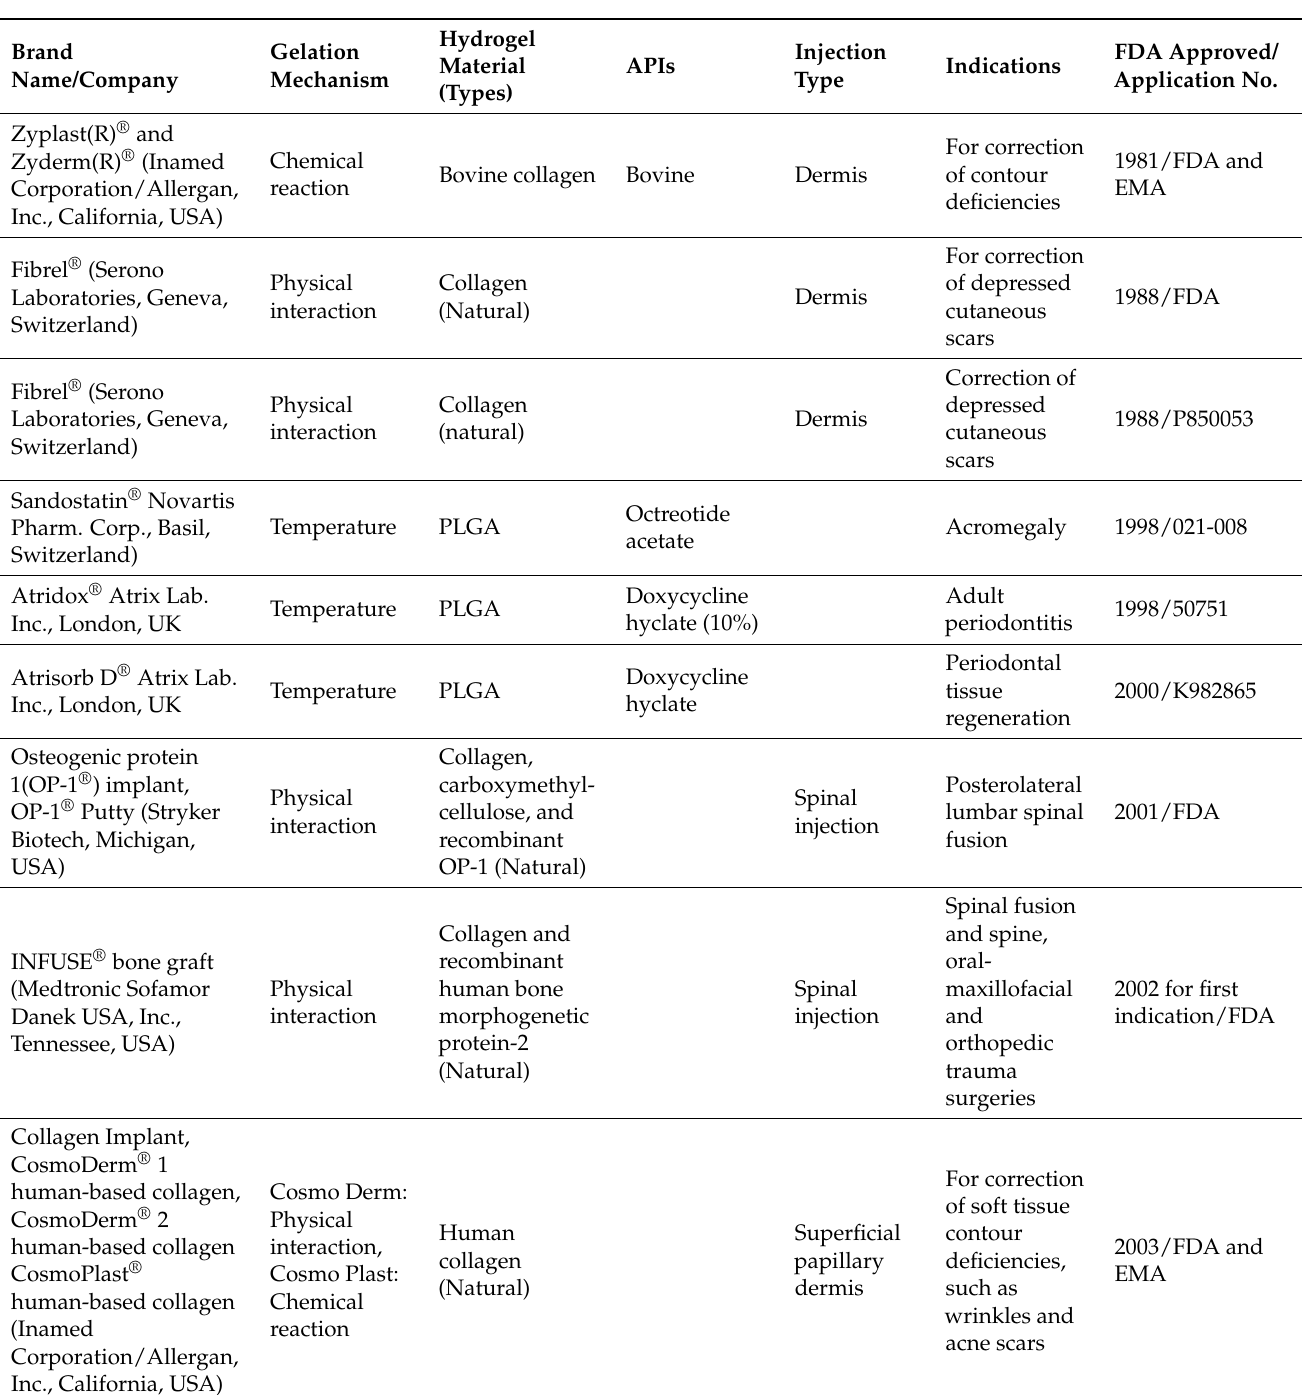
Table 4. FDA clinically approved injectable hydrogel